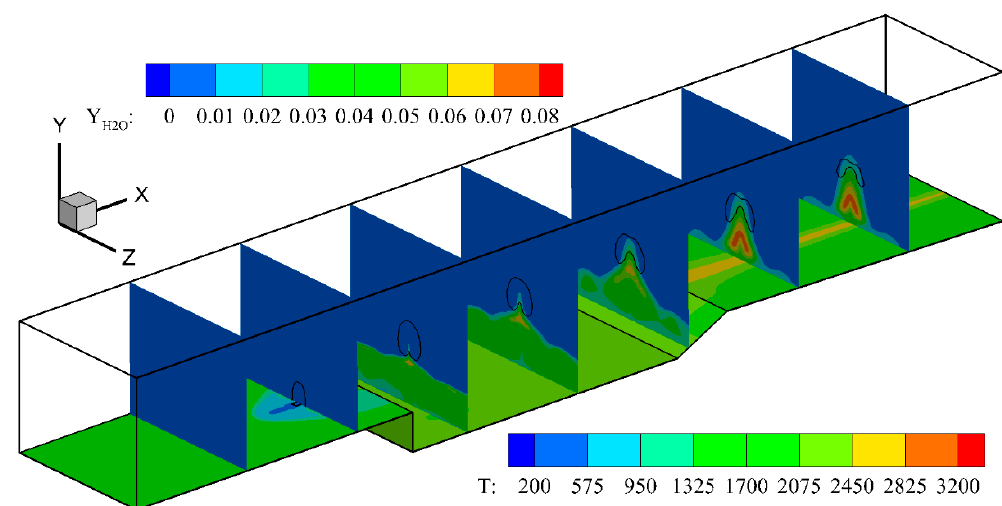
Figure 3. Comparison of the time-averaged flame during stable combustion before and after the condition transition (Upper images: condition 1; Lower images: condition 2).